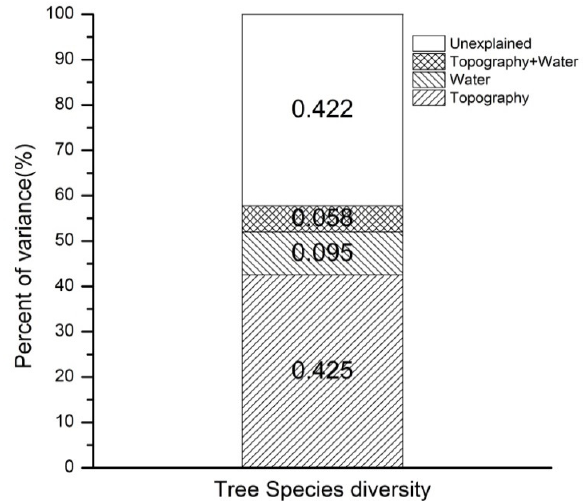
Figure 4. Variance partitioning with partial RDA of tree species diversity based on topography and soil water. Monte Carlo permutation test was performed on each set without the effect of the other by permuting samples freely (999 permutations).